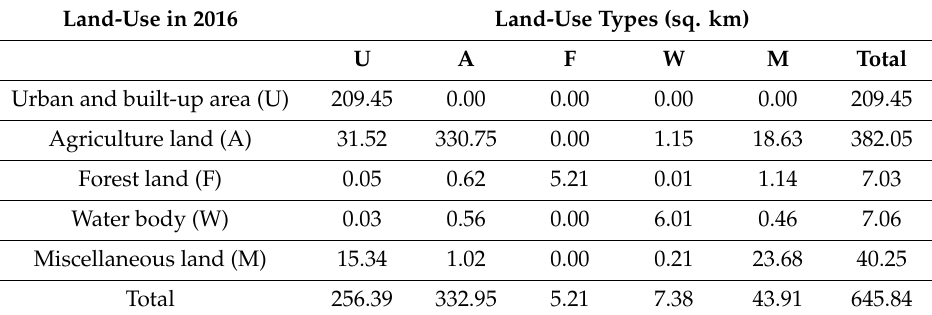
Urban and built-up area (U)